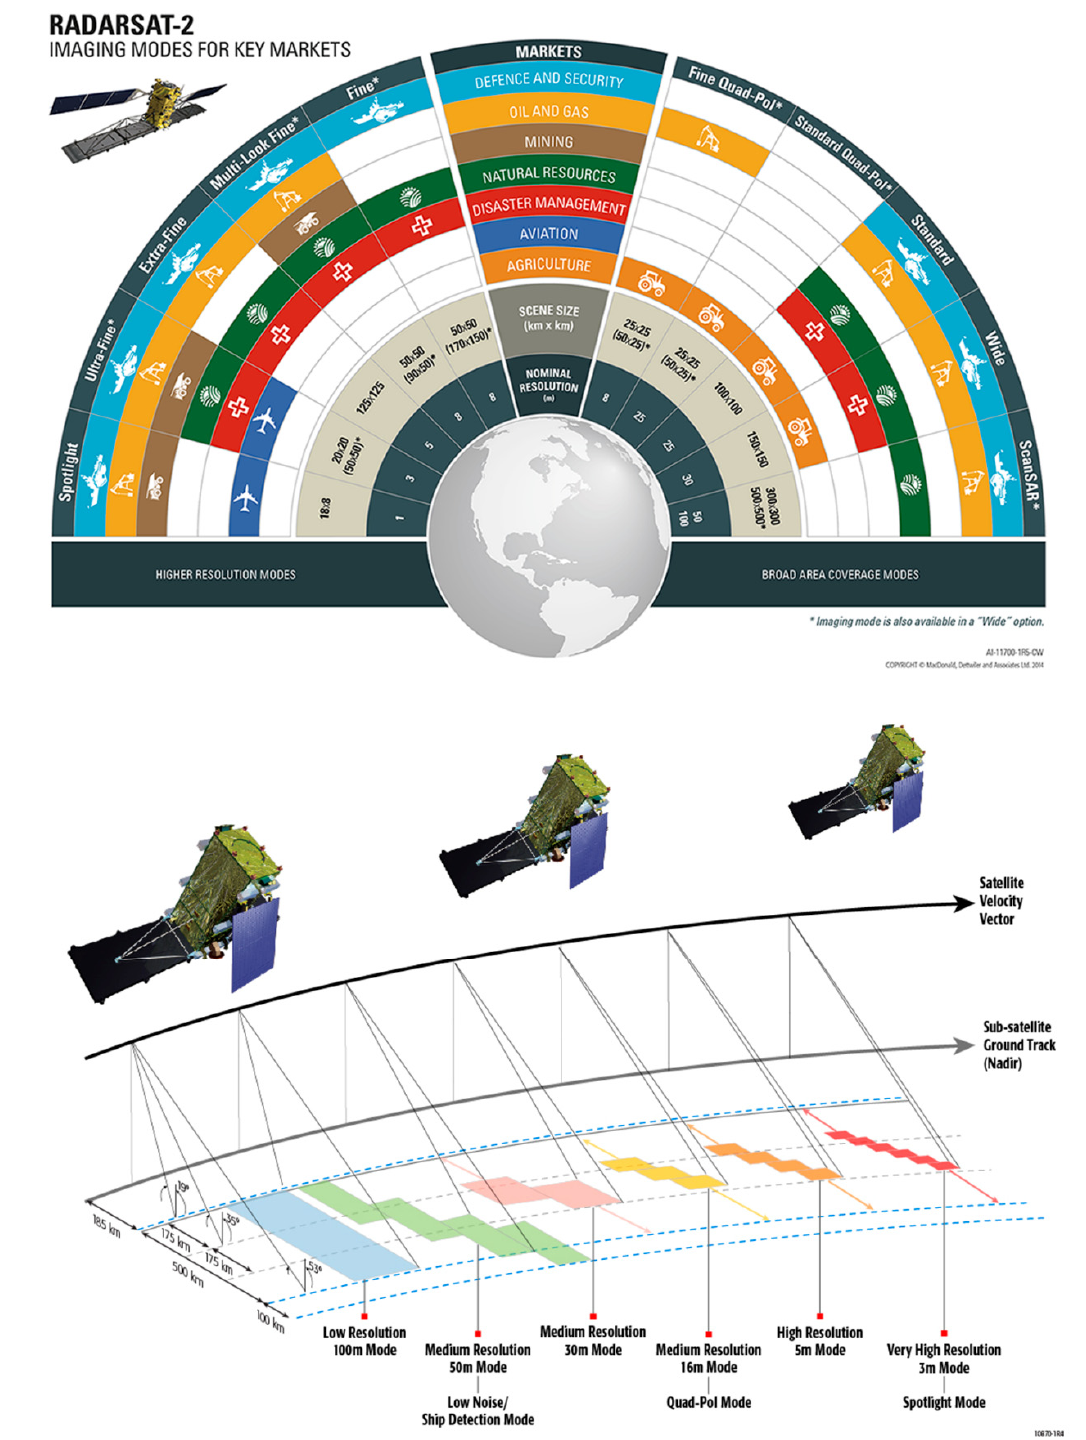
Figure 2. A comparison of RADARSAT-2 and the RADARSAT Constellation Mission (RCM) swath widths. These graphics illustrate that a wider swath width will be available for many beam modes on the RCM compared to RADARSAT-2. Reproduced by permission of/or Courtesy of MacDonald, Dettwiler and Associates